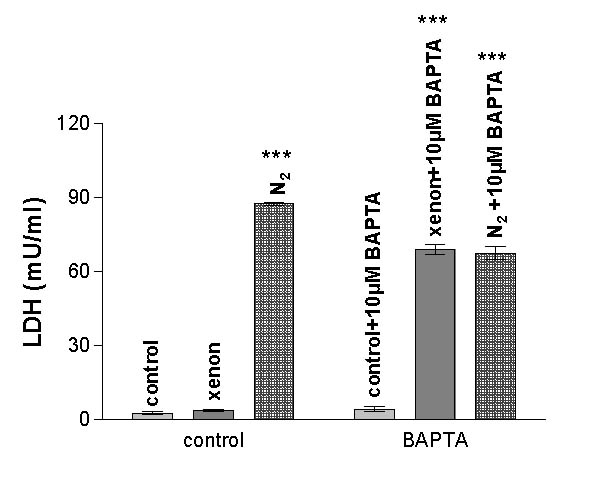
Effects of intracellular Ca2+-buffering by BAPTA. If PC-12 cells were preloaded with 10 μM BAPTA, the neuroprotective effect of xenon was strongly reduced. At the same time, however, a small reduction in cellular damage was observed in nitrogen-treated cells. (n = 5; P < 0.0001 analyzed by 2-way ANOVA and Bonferroni posttests between BAPTA-treated and untreated groups; no significant difference was found when the nitrogen-group was compared to the nitrogen-BAPTA group).